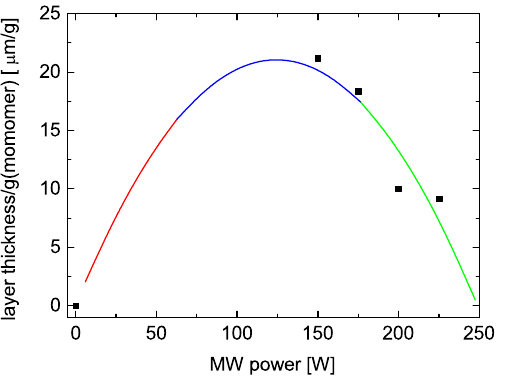
Figure 16. According to Yasuda, the regimes of power deficit and abundance of power are separated by optimum power input